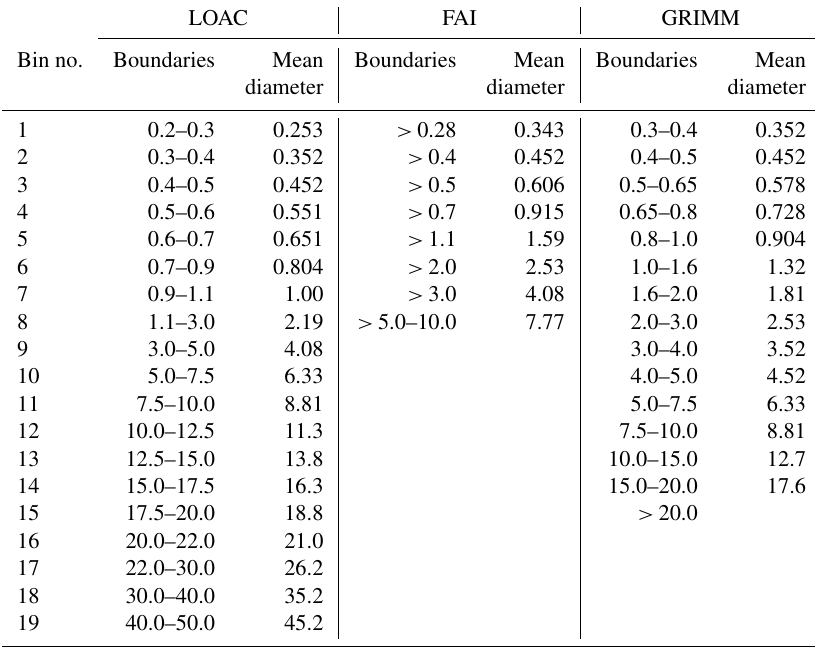
Table 2. Size bins of the three OPCs. All reported values are in micrometers (µm). LOAC FAI Bin no.